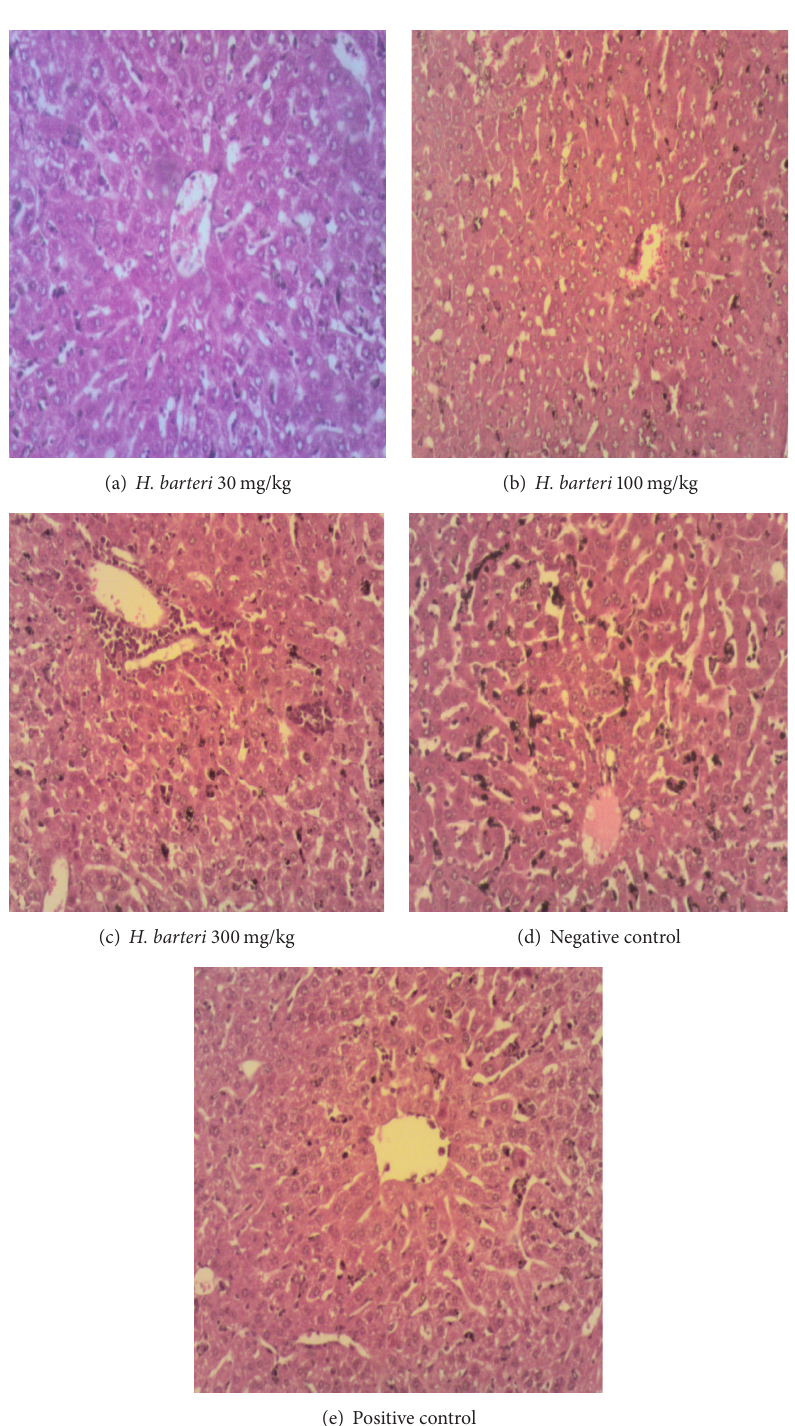
Figure3:Sectionsofliverunderhighmagnification(100x).(a) H.barteri (30 mg/kg),extracttreatedliver:fewhepatocytescontainmerosome, and central vein and portal triad appear normal; (b) H. barteri (100 mg/kg), extract treated liver: hepatic necrosis and Kupffer cell hyperplasia; (c) H. barteri (300 mg/kg), extract treated liver: mild haemosiderosis, Kupffer cell hyperplasia, and hepatic necrosis, with traces of periportal mononuclear cells infiltration; (d) liver of negative control mouse: severe hepatic necrosis with Kupffer cells hyperplasia and haemosiderosis; (e) artemether/lumefantrine treated liver: mild hepatic necrosis and traces of periportal mononuclear cells